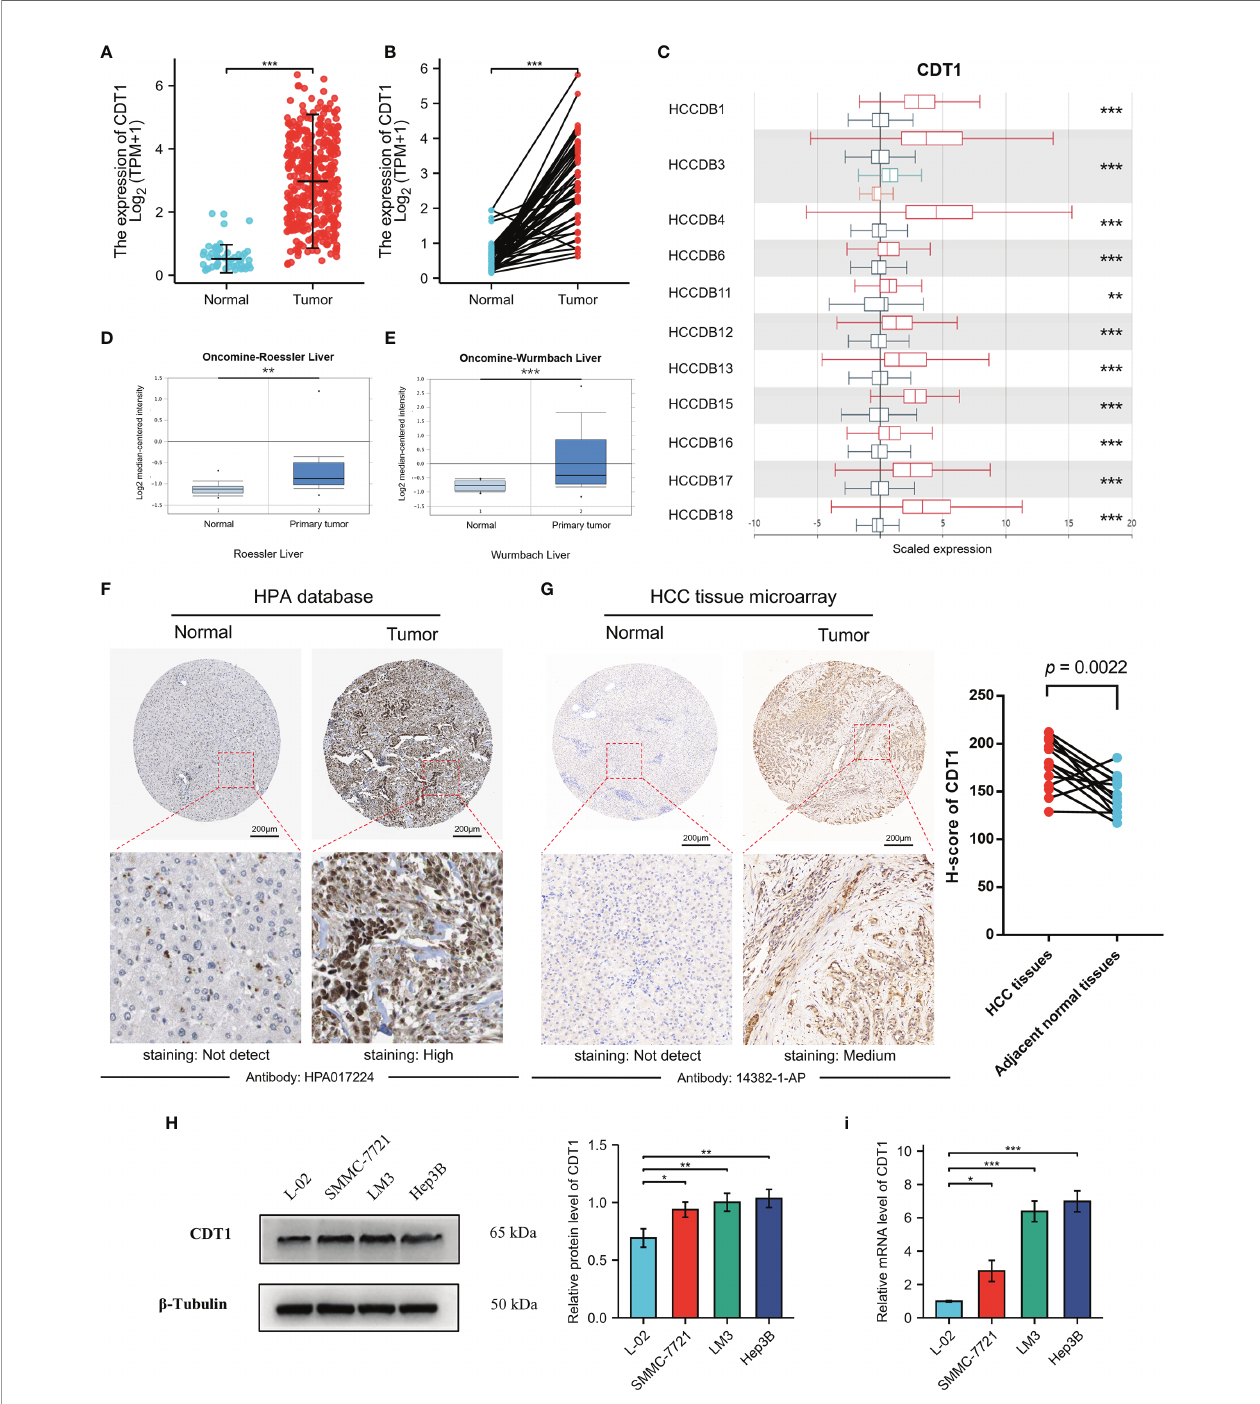
FIGURE 3 | The relative expression of CDT1 in HCC at the cell and tissue levels. (A) CDT1 expression in normal and tumor tissues (TCGA and GTEx). (B) CDT1 expression in paired tissues (TCGA and GTEx). (C) The mRNA level of CDT1 in different HCC datasets (HCCDB). (D, E) CDT1 mRNA expression in normal and tumor tissues (ONCOMINE). (F) The protein expression level of CDT1 in HCC and normal liver tissues (HPA). (G) The IHC staining results of CDT1 level in HCC and adjacent non-tumor tissue (clinical tissue microarray of HCC) and the corresponding scatter diagram. Statistical signi fi cance was determined by paired t-test. (H, I) Western blot and qRT-PCR results of CDT1 expression in normal human liver cell line and HCC cell lines. Data are expressed as means ± SD. * p < 0.05, ** p < 0.01, *** p <